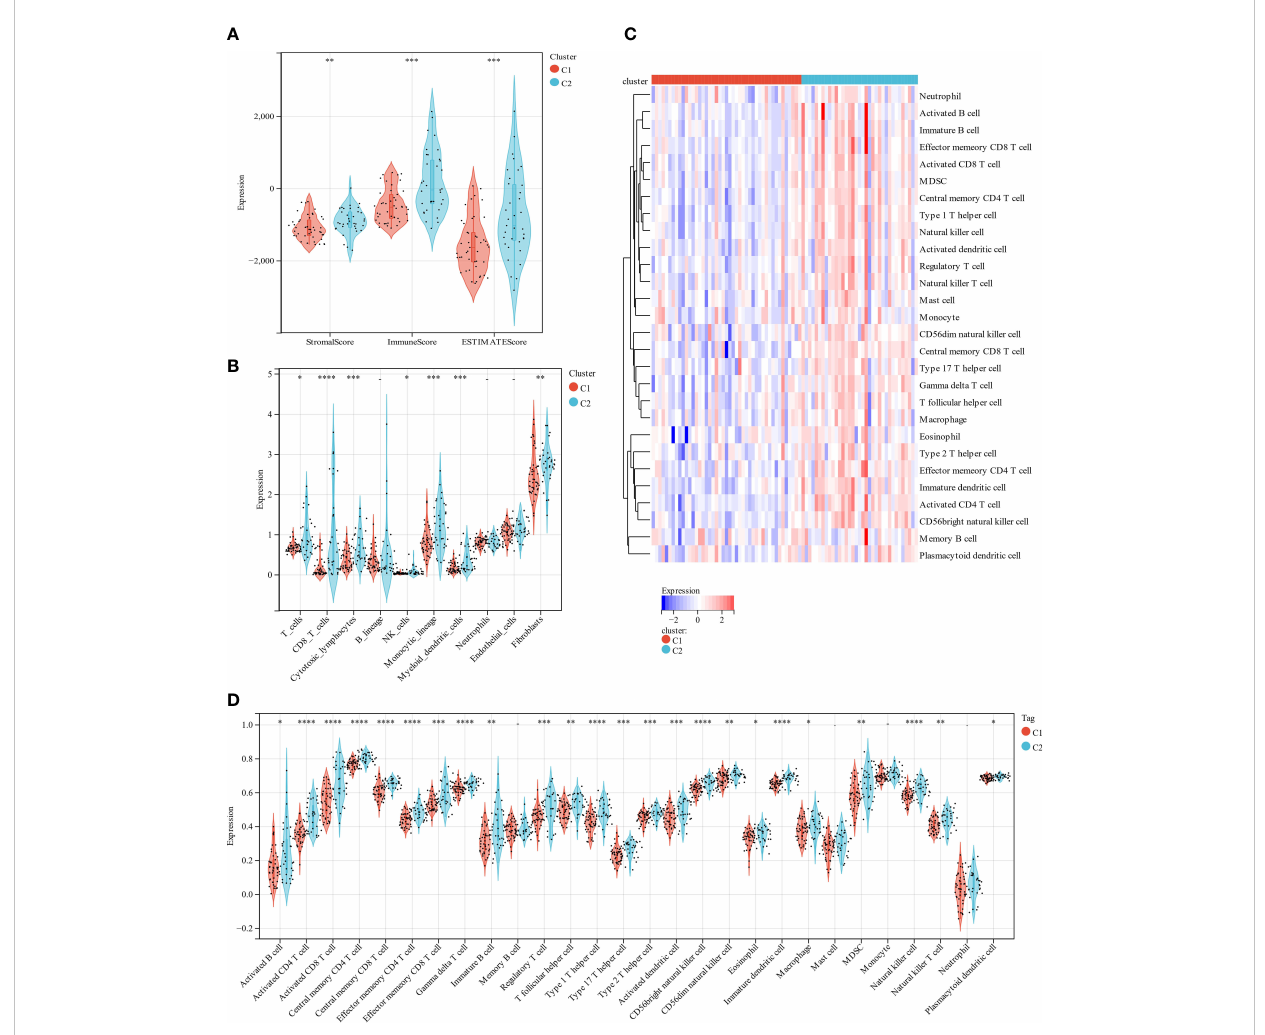
FIGURE 4 A comparison of immune in fi ltration between the two clustered subgroups. (A) The Violin diagram presented the calculation of stromal score, immune score, and estimate score in two subgroups. (B) MCP evaluated the abundance of ten immune fi ltrating cells. (C) A heatmap displays the level of enrichment for 28 immune-related cells based on a ssGSEA algorithm. (D) Statistical analysis of ssGSEA. *p < 0.05; **p < 0.01; ***p < 0.001 ****p <